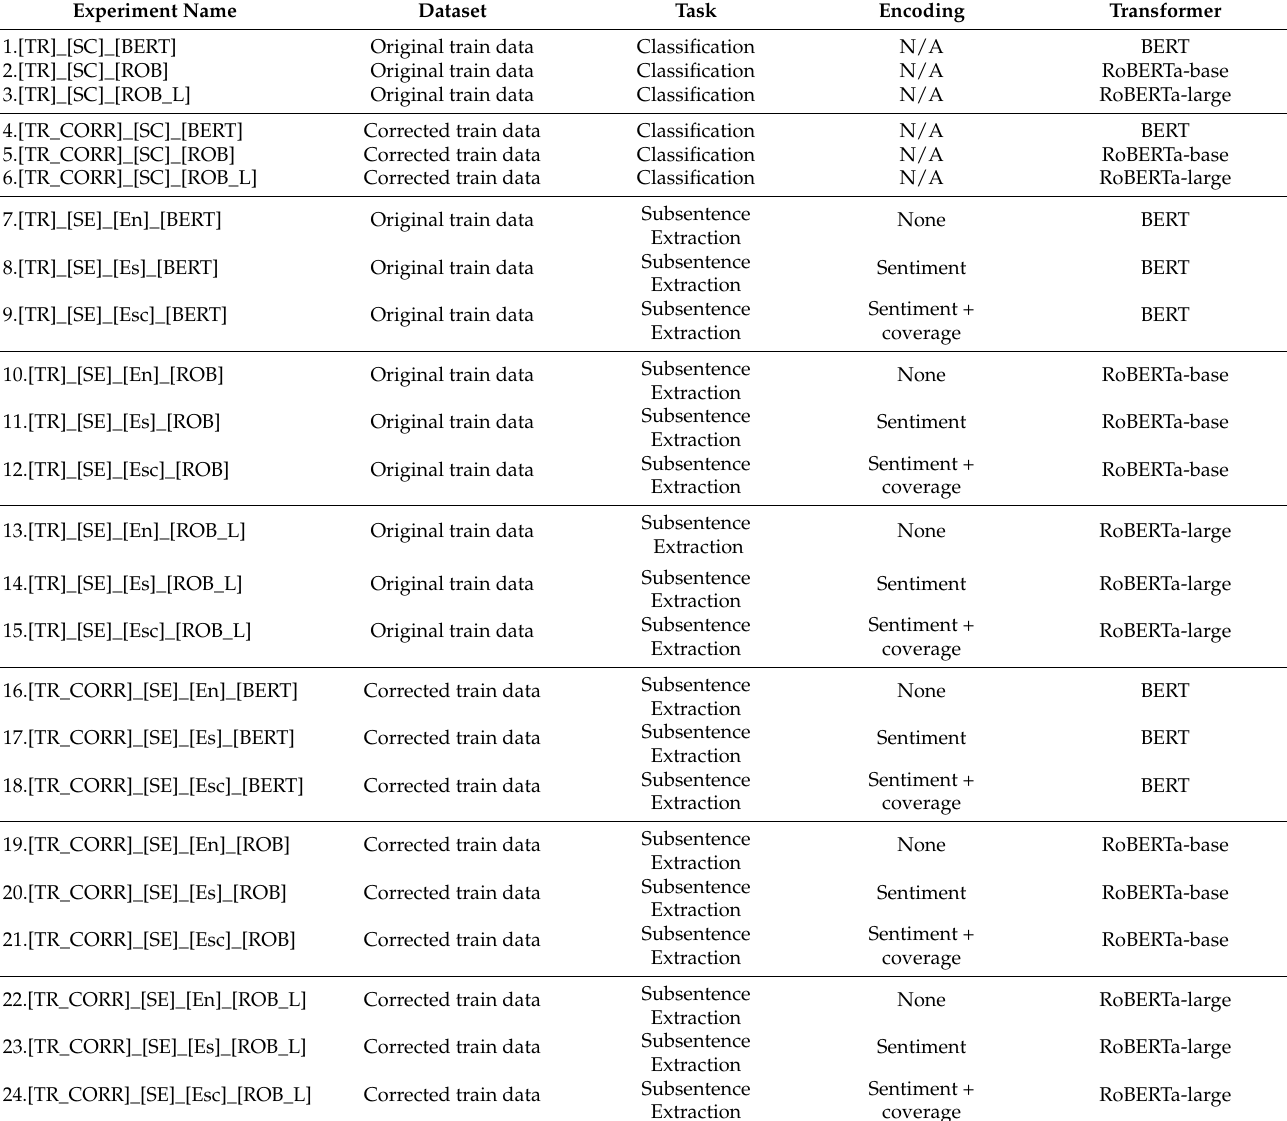
Table 1. All experiments’ names and descriptions. Experiment naming convention used across all sections